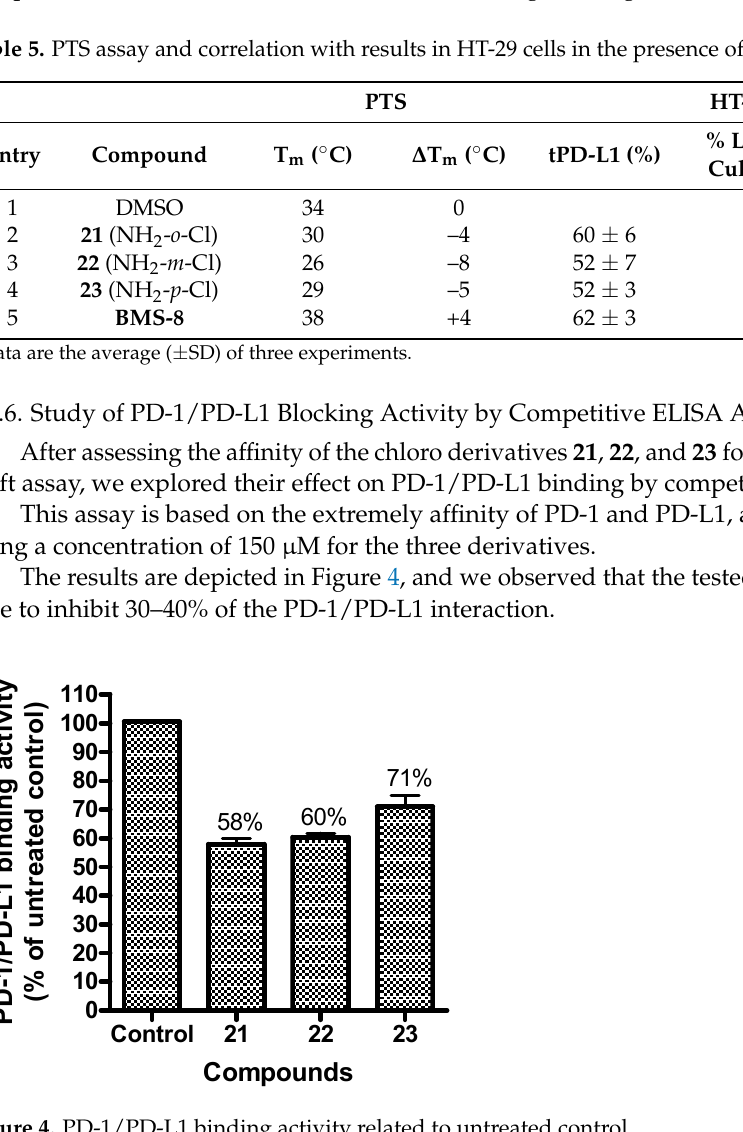
Figure 4. PD-1/PD-L1 binding activity related to untreated control.